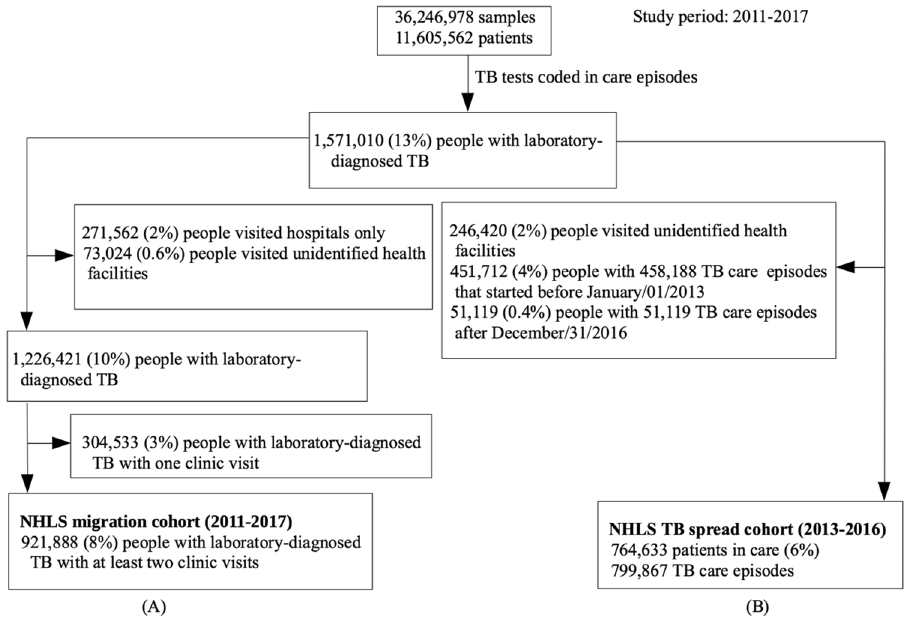
Figure 4. Flow diagram of our migration cohort ( A ) and tuberculosis spread cohort ( B ). The cohorts were created using tuberculosis laboratory results, which were linked to identify individuals, from South Africa’s National Health Laboratory Service database. We used the migration cohort to assess cross-municipality migration in people with laboratory-diagnosed tuberculosis and tuberculosis spread cohort to quantify the role of migration in tuberculosis